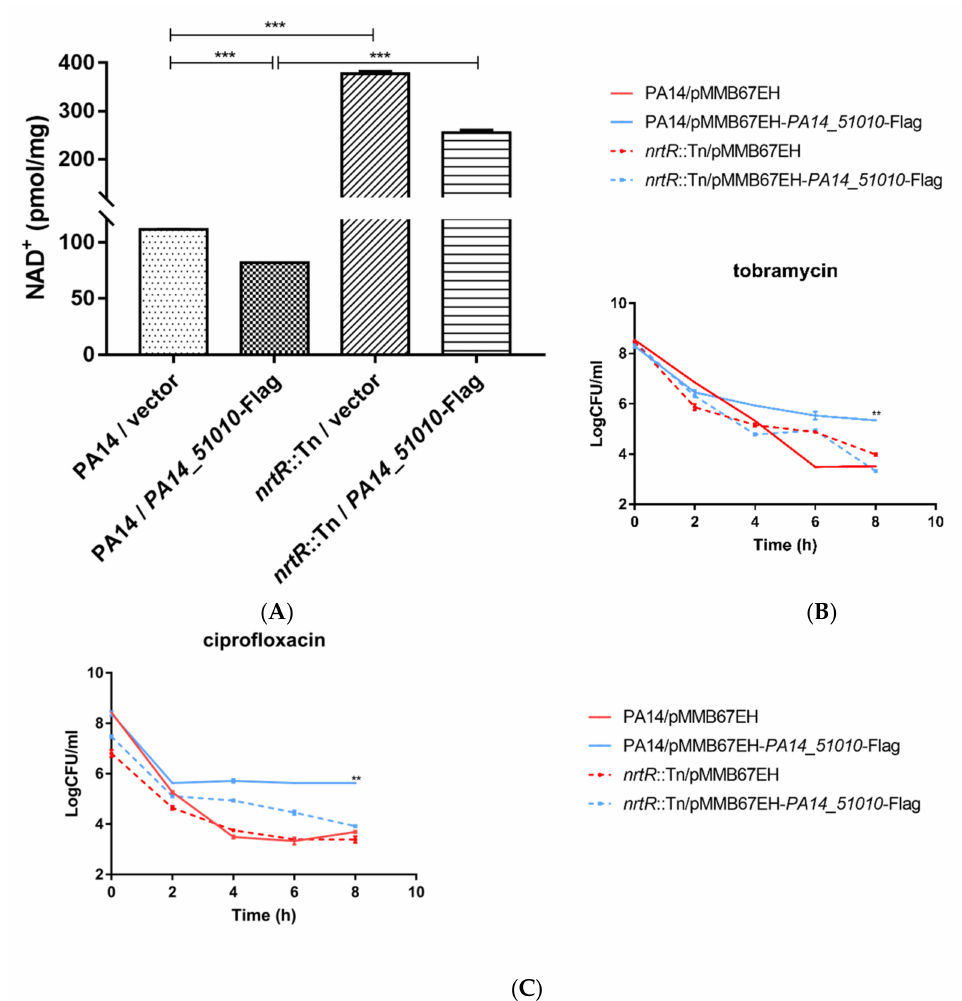
Figure 6. Over production of NAD + counteracts the effect of overexpression of PA14_51010 in persister formation. ( A ) Wild-type PA14 and the nrt R::Tn mutant carrying pMMB67EH or pMMB67EH- PA14_51010 -Flag were cultured in LB in the presence of 1 mM IPTG to an OD 600 of 1.0. The bacteria were collected by centrifugation and washed three times with PBS. The relative quantity of NAD + was normalized by the total protein amount. ***, p < 0.001, by Student’s t test. ( B , C ) Wild-type PA14 and the nrtR ::Tn mutant carrying pMMB67EH or pMMB67EH- PA14_51010 were cultured in LB in the presence of 1 mM IPTG to an OD 600 of 1.0. The bacteria were treated with 5 µ g/mL tobramycin ( B ) or 0.5 µ g/mL ciprofloxacin ( C ). At indicated time points the live bacteria numbers were determined by serial dilution and plating. Data represent the results from three independent experiments. **, p < 0.01 compared to the other samples by Student’s t